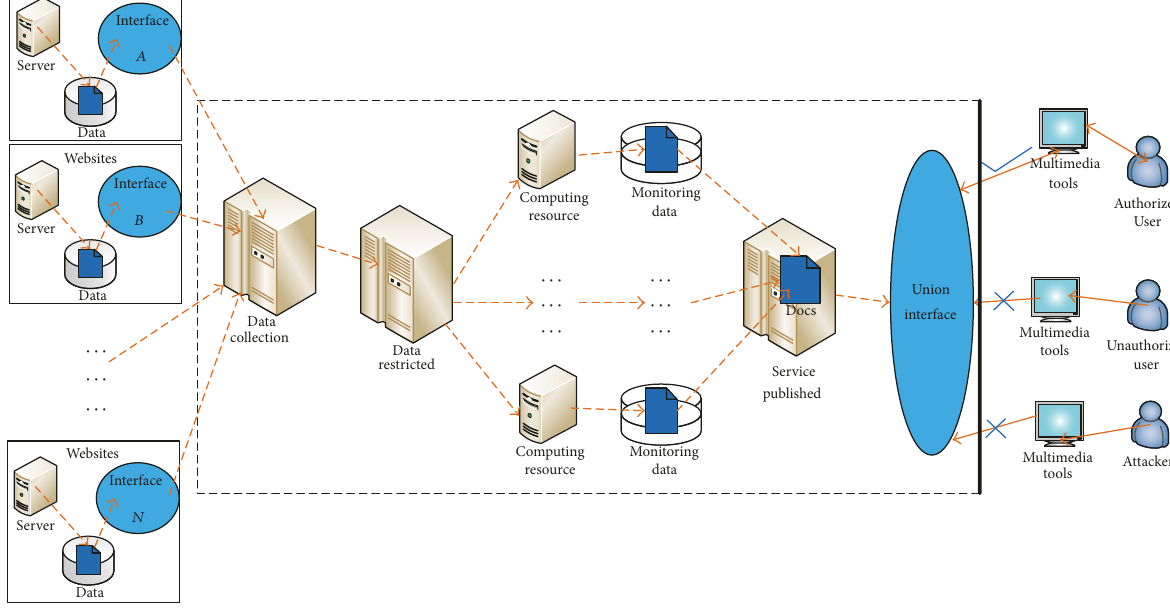
Figure 3: Work flow of the e-commerce